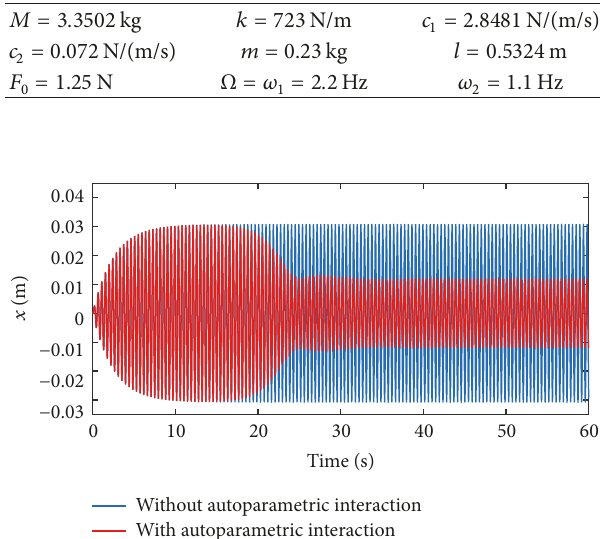
Figure 2: Simulation response for the primary system with and without autoparametric